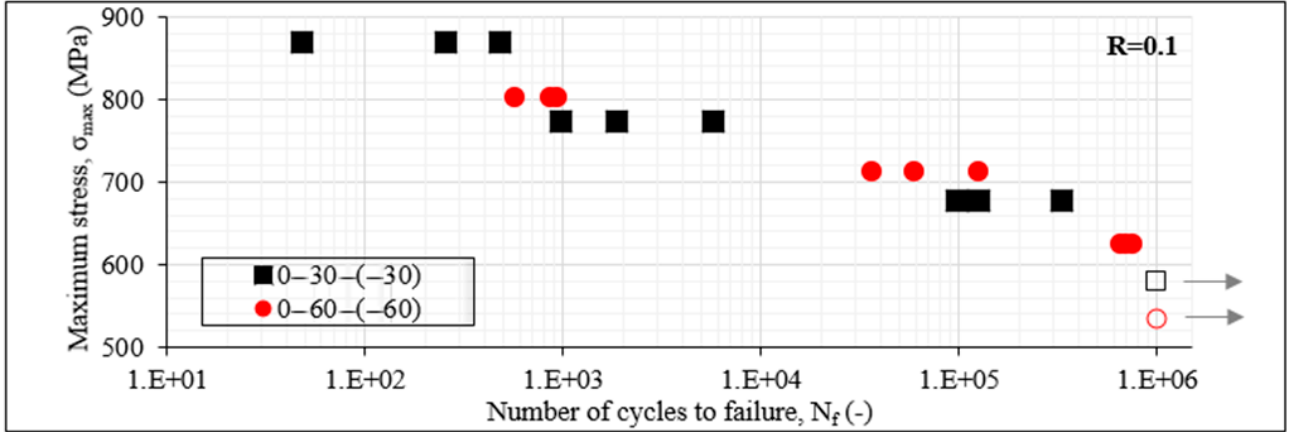
Figure 6. S-N f data of [0°/30°/ − 30°] 2s and [0°/60°/ − 60°] 2s laminates for R = 0.1.